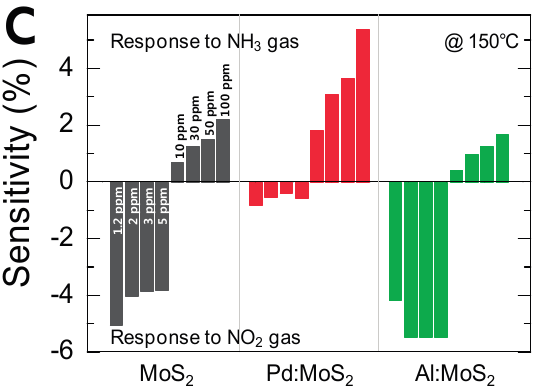
Figure 3. Transient gas responses under NH 3 100 ppm and NO 2 5 ppm before/after ( a ) Pd decoration on MoS 2 and ( b ) Al decoration on MoS 2 ; ( c ) Sensitivity summary of MoS 2